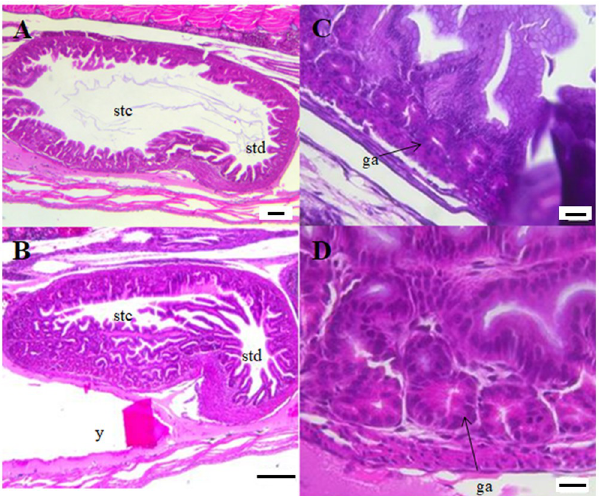
Fig 5. Longitudinal sections of the stomach (A-B) and gastric glands (C-D) of diploid and triploid Atlantic salmon at start-feeding (0 ddPSF). (A) Diploid individual (2n). (B) Triploid individual (3n). (C) Gastric glands in the cardiac part of the stomach (2n). (D) Gastric glands in the cardiac part of the stomach (3n). ga. gastric pits; stc. stomach cardiac; std. stomach posterior; y. yolk sac. Scale. A. 100 μ m. B. 200 μ m. C-D. 20 μ m.